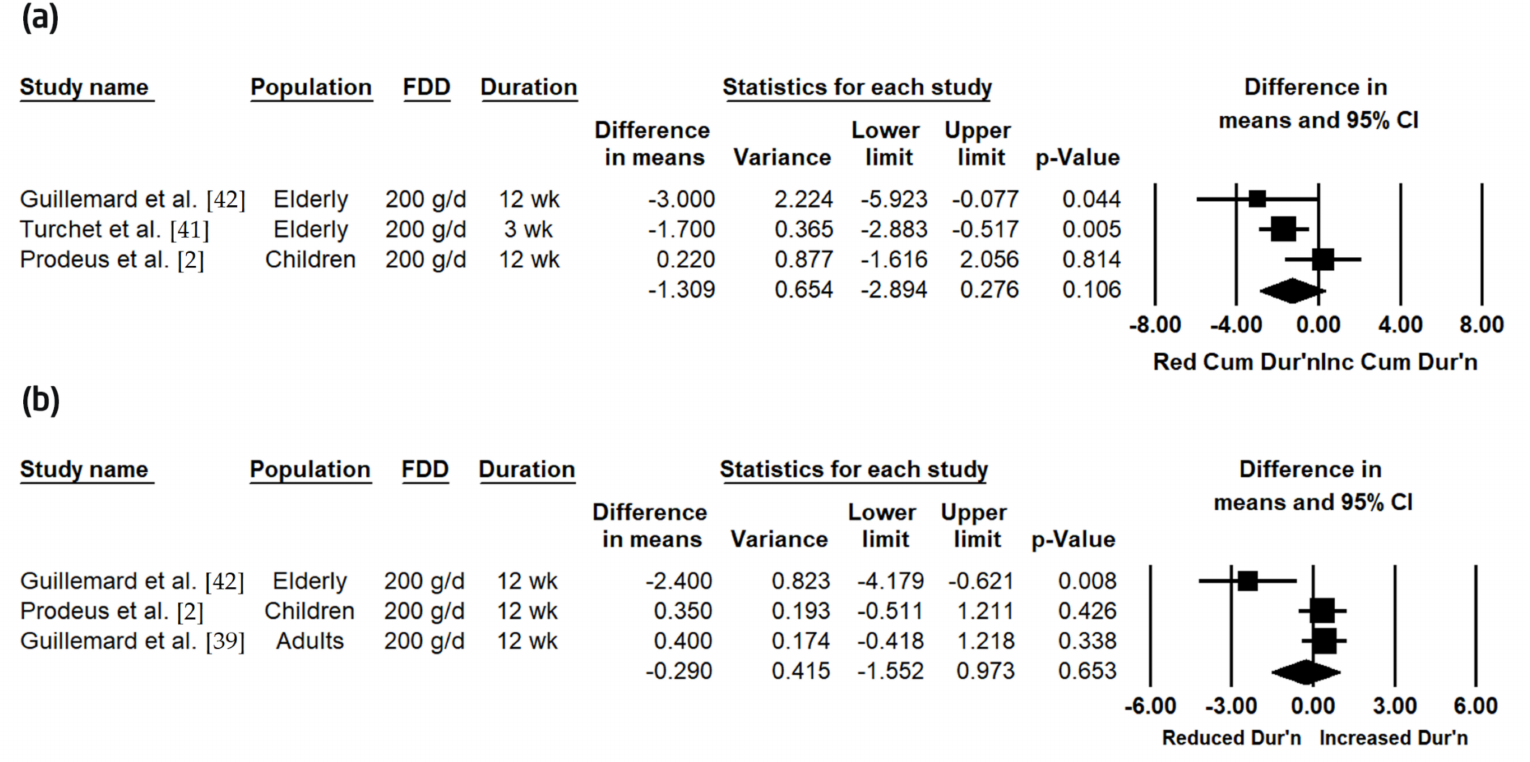
Figure 3. E ff ects of the fermented dairy drink containing Lacticaseibacillus paracasei subsp. paracasei CNCM I-1518 and the standard yogurt cultures (FDD) compared to the control on: ( a ) the mean cumulative days of common infectious diseases (CIDs) amongst subjects with CIDs; ( b ) the mean number of days per CID episode amongst subjects with CIDs. CI: confidence interval; cum dur’n: cumulative duration; dur’n: duration; g / d: g / day; wk: